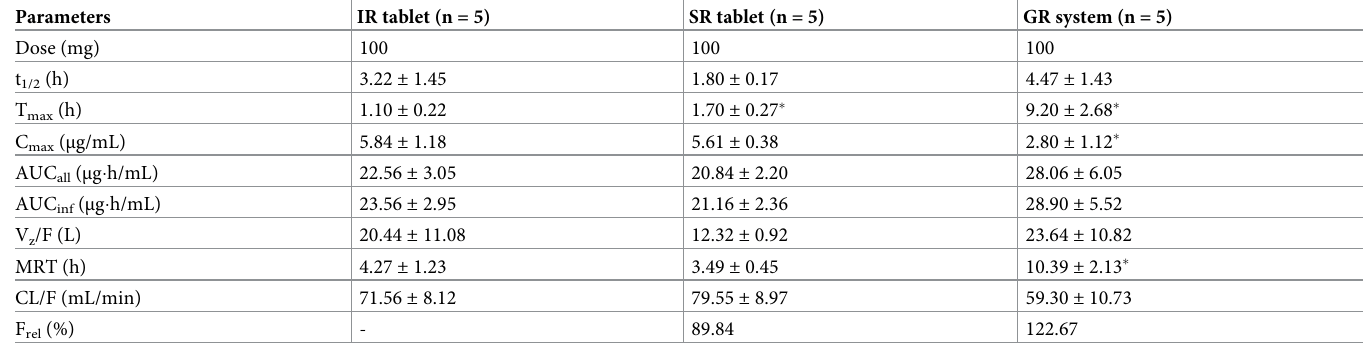
Table 1. Non-compartmental pharmacokinetic parameters of acyclovir after oral administrations of immediate release (IR) tablet, sustained release (SR) tablet, or gastroretentive (GR) system in Beagle dogs (n = 5).